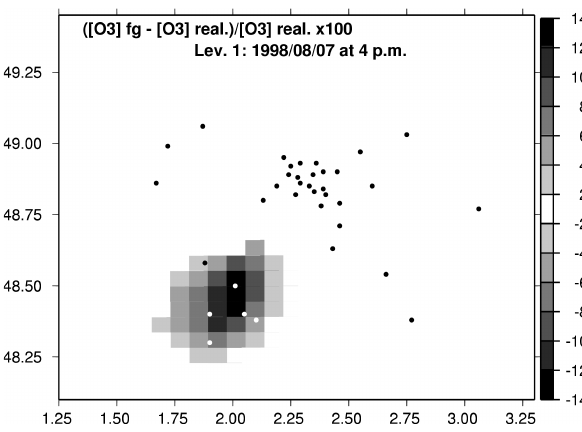
Table 1. Average scores of optimizations (in %) (and matching variances) for NO x inversion with two types of NO or ozone constraints. x = convergence not reached.